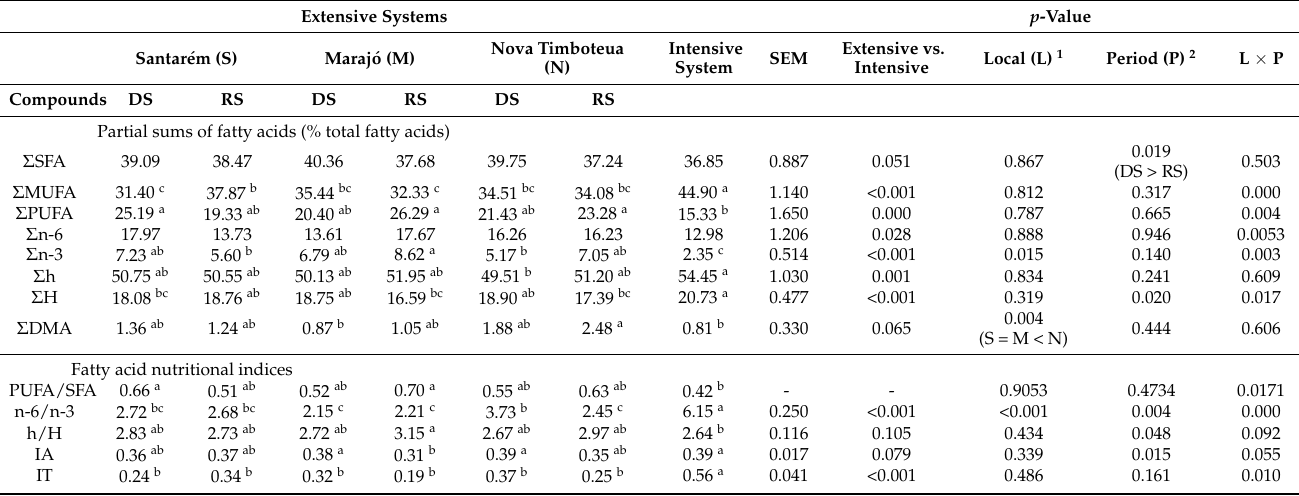
Table 4. Partial sums of fatty acids and fatty acid nutritional indices of ribeye muscle of crossbred buffaloes ( n = 12) raised extensively in three types of production systems, during dry (DS) and rainy (RS) seasonal periods, or intensely in feedlot, in Eastern Amazonia (Brazil). Extensive Systems p -Value Extensive vs.